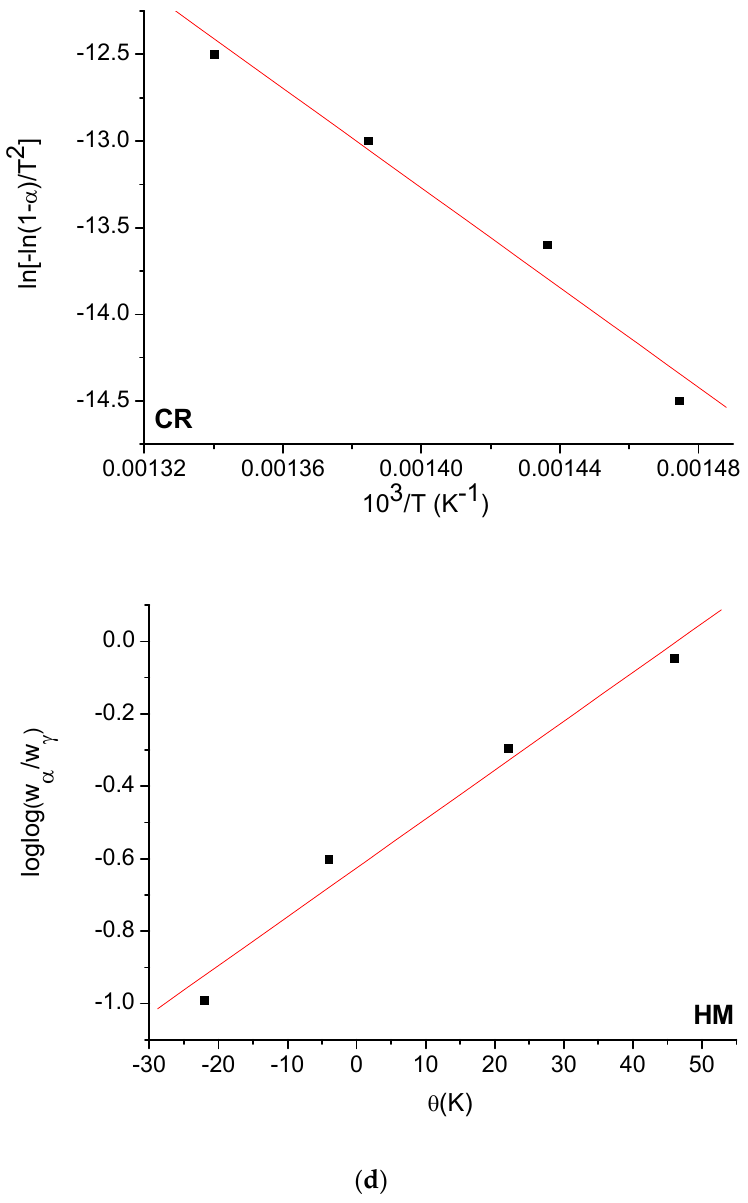
Figure 9. ( a ) HM and CR curves of free OFL drug; ( b ) HM and CR curves of Complex 1 ; ( c ) HM and CR curves of Complex 2 ; ( d ) HM and CR curves of Complex 3 . Table 6. Thermodynamic parameters of the thermal decomposition of free OFL and the synthesized complexes.